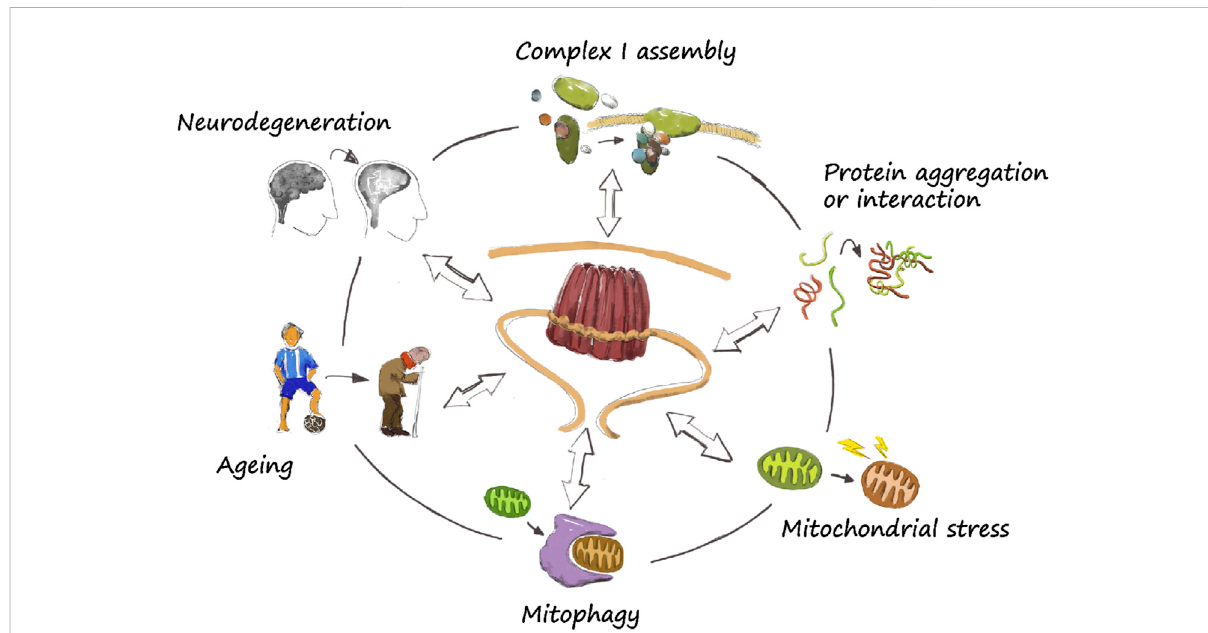
FIGURE 2 The prohibitin wheel. The role of PHBs in mitochondrial homeostasis is diverse. They directly participate inspeci fi cfunctions such as complex I assembly, protein aggregation and turnover, mitochondrial stress and mitophagy. They have been also described to have a role in ageing and neurodegeneration, although the exact mechanism by which they regulate lifespan or neuroprotection is still unclear. Nevertheless, a correct functioning of mitochondria is necessary, so a dysregulation of basic mitochondrial functions may lead to